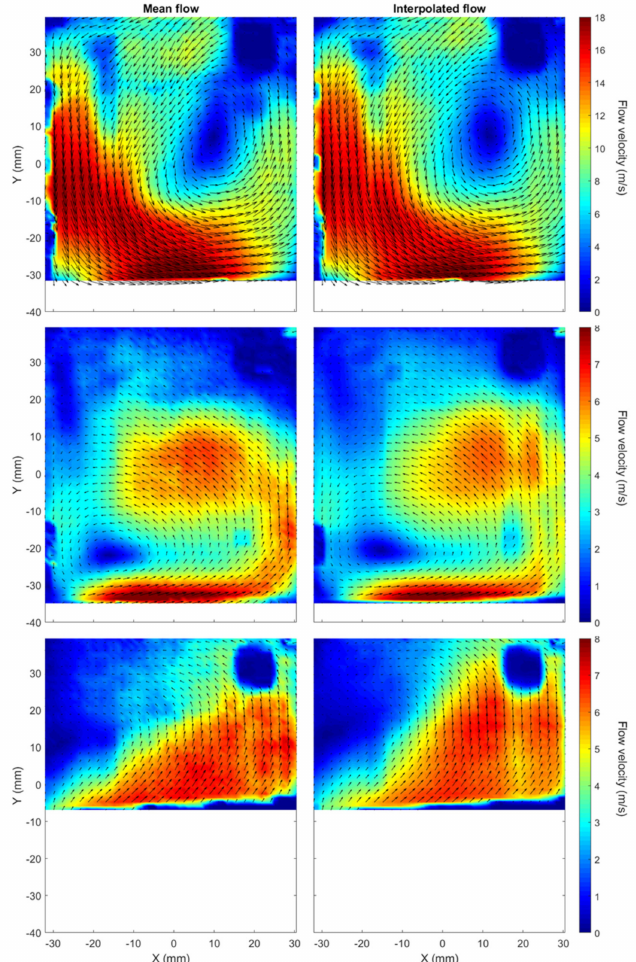
Figure 14. Mean field outside the POD decomposition and interpolated field; θ = 130, 220 and 270 ◦ CA. (from top to bottom); θ VVT = 25 ◦